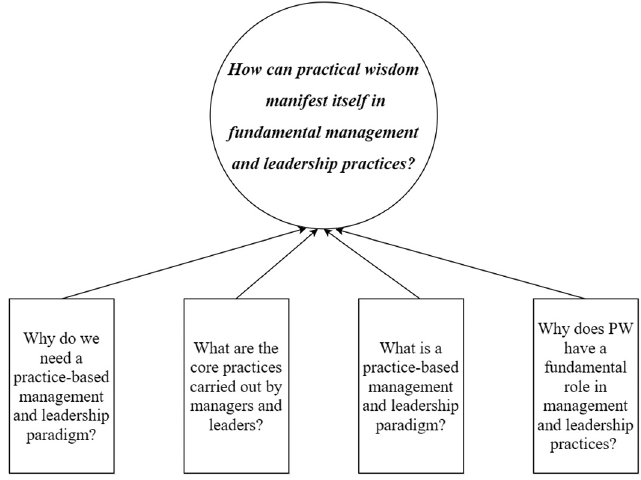
Figure 1. Research